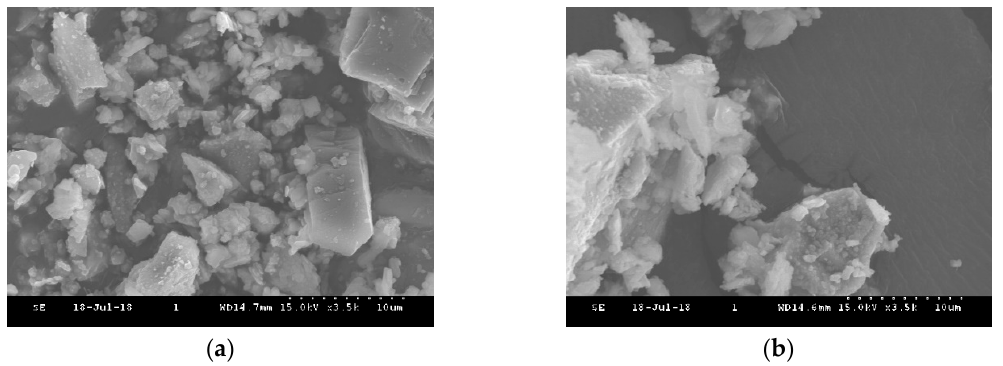
Figure 8. SEM images of the mixed samples: ( a ) Room temperature; ( b ) 440 ° C.